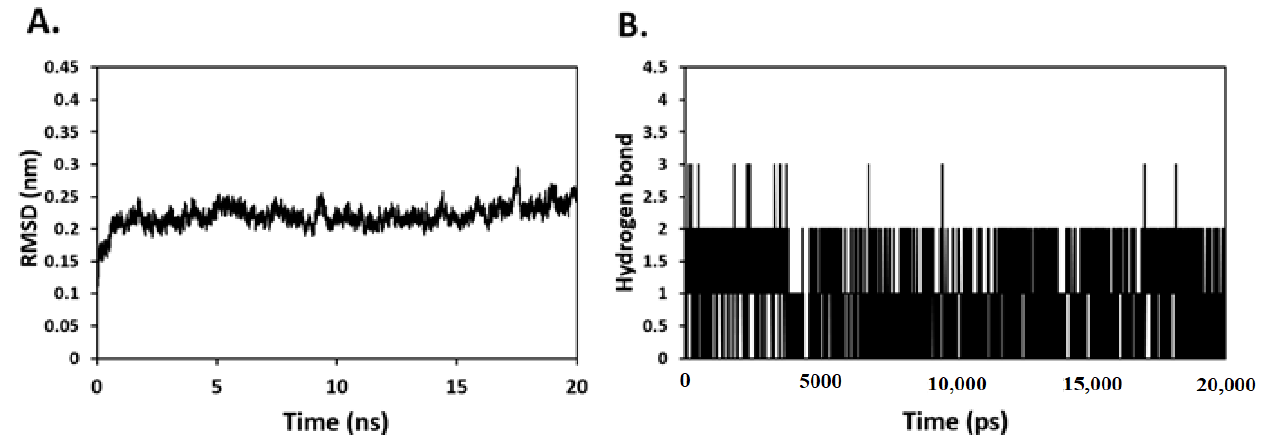
Figure 5. ( A ) The backbone RMSD of M6-EGFR complex for 20 ns MD simulation. ( B ) Total number of molecular hydrogen bonds for the M6-EGFR complex over the simulation time.